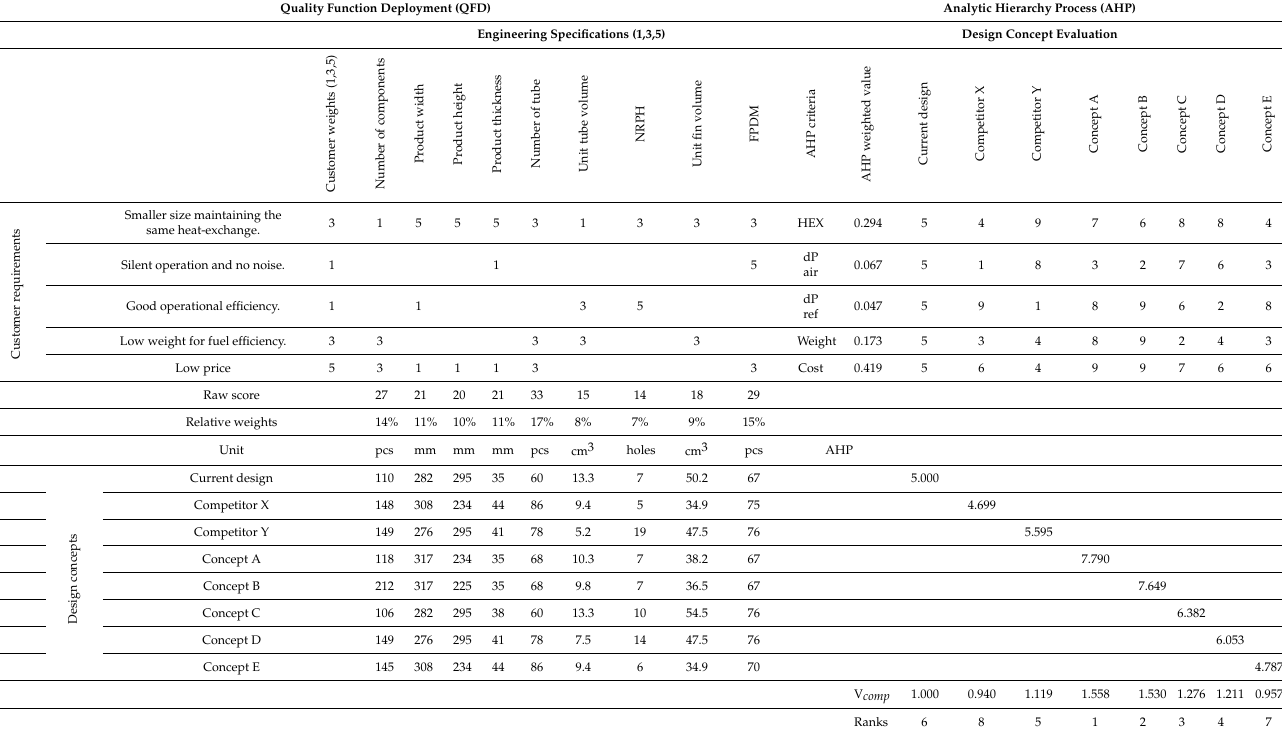
Table A1. Concept competitiveness scores and rankings from the QFD–AHP